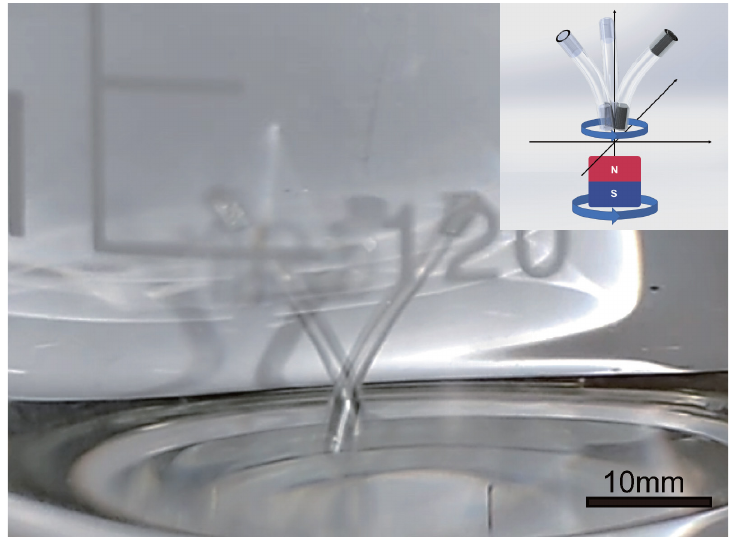
Figure 11. Stirring mode and physical demonstration. The MHCMM has the function of stirring in water, which is driven by the external magnetic